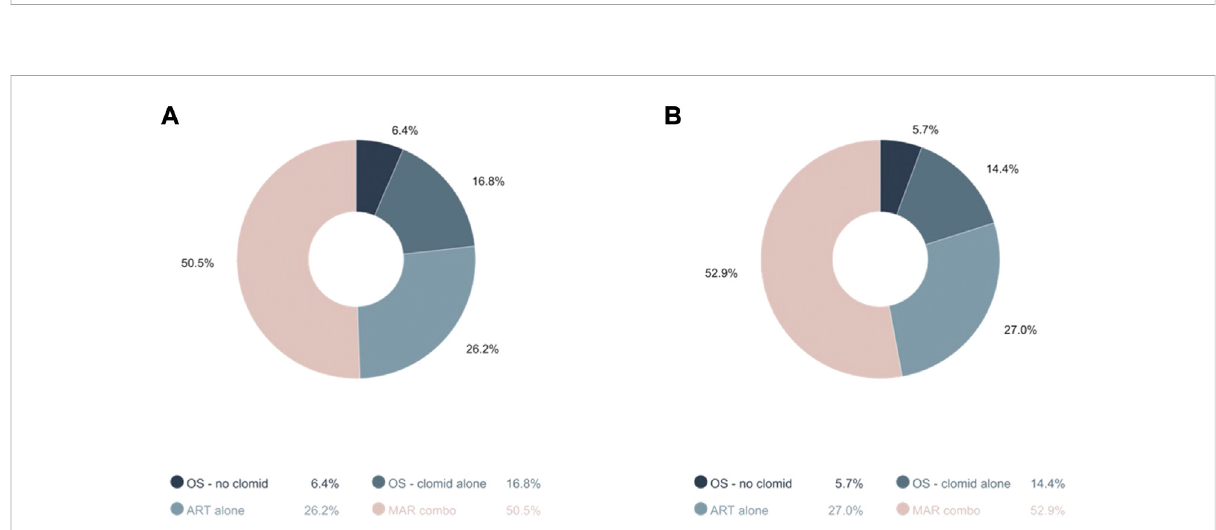
FIGURE 2 Distribution of MAR categories among (A) pregnancies resulting in SGA ( n = 202) and (B) non-SGA babies ( n = 1,860). Legend: ART, assisted reproduction techniques; MAR, medically assisted reproduction; OS, ovarian stimulators; SGA, small for gestational age.